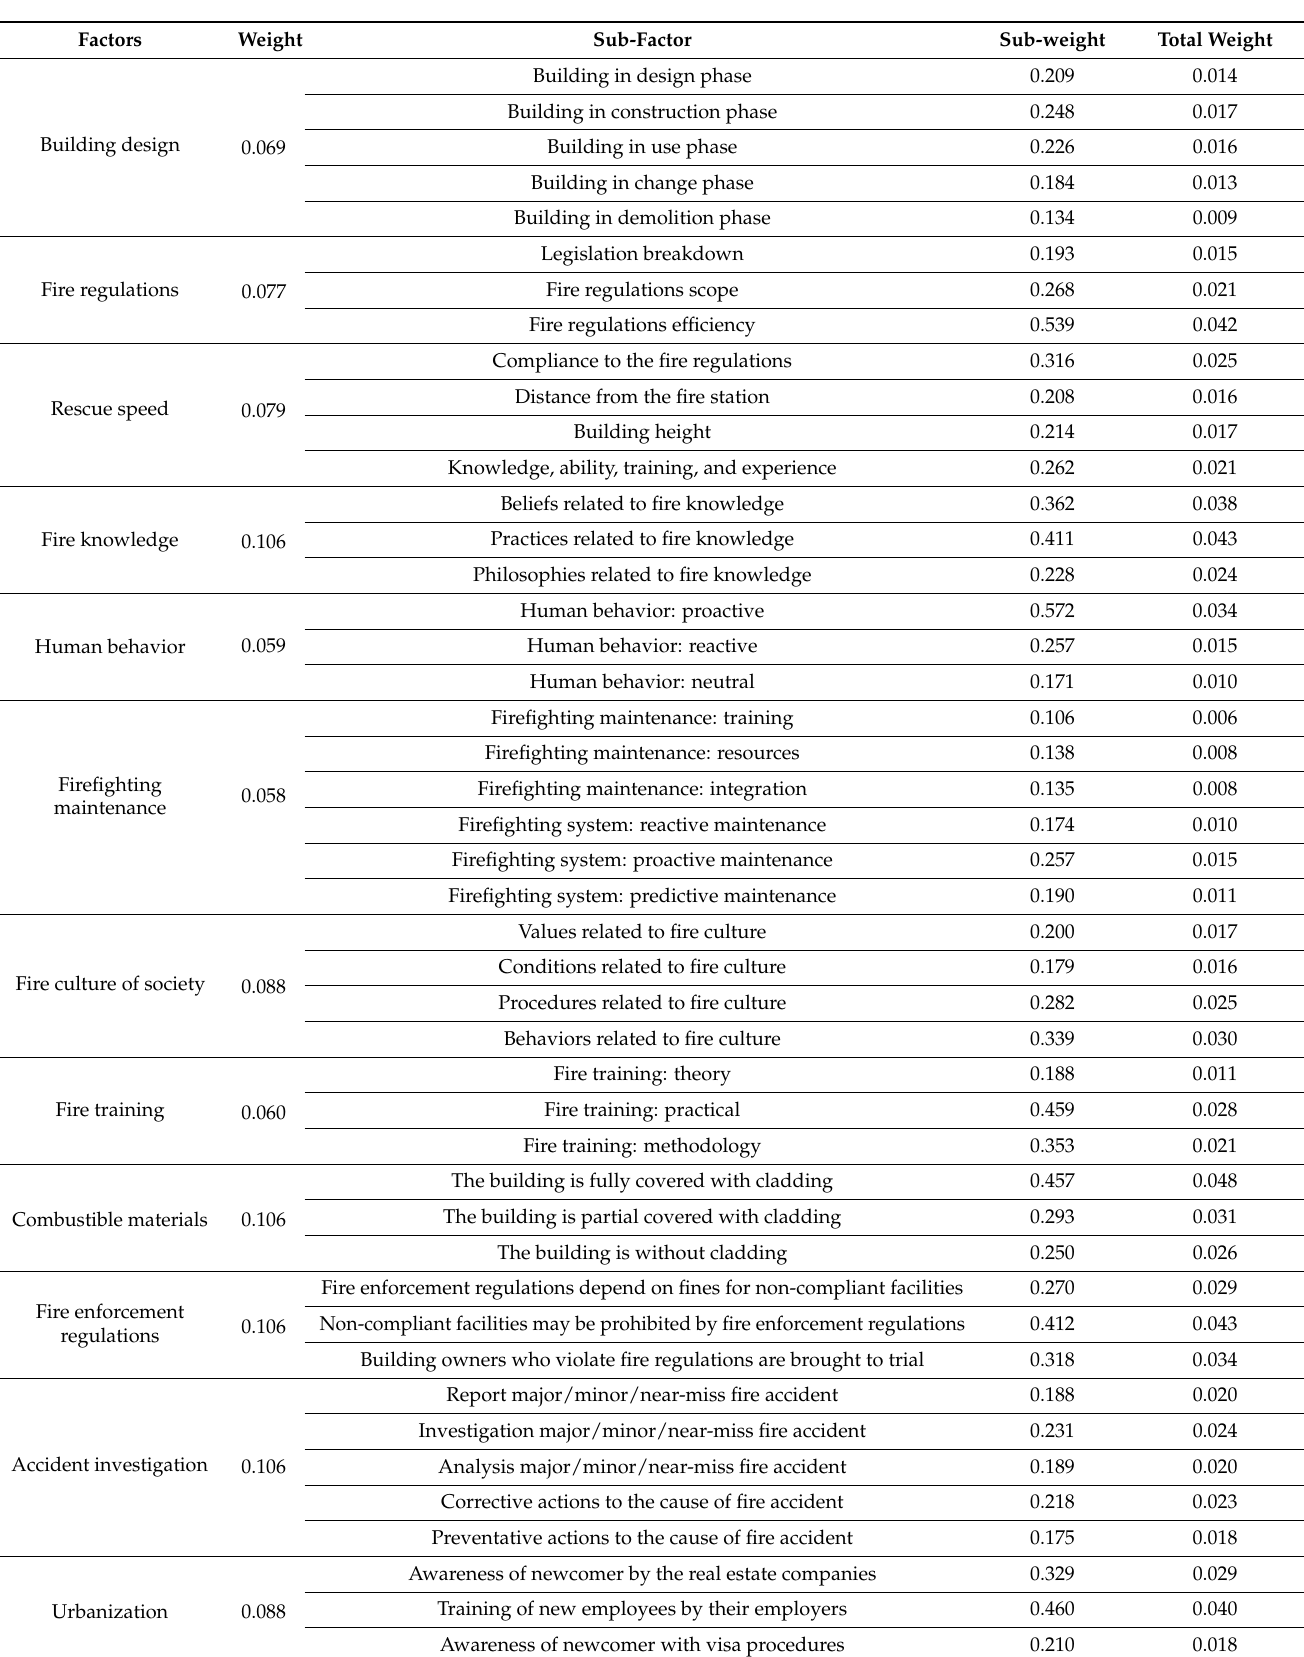
Table 8. Sub-factors affecting the fire management system in the